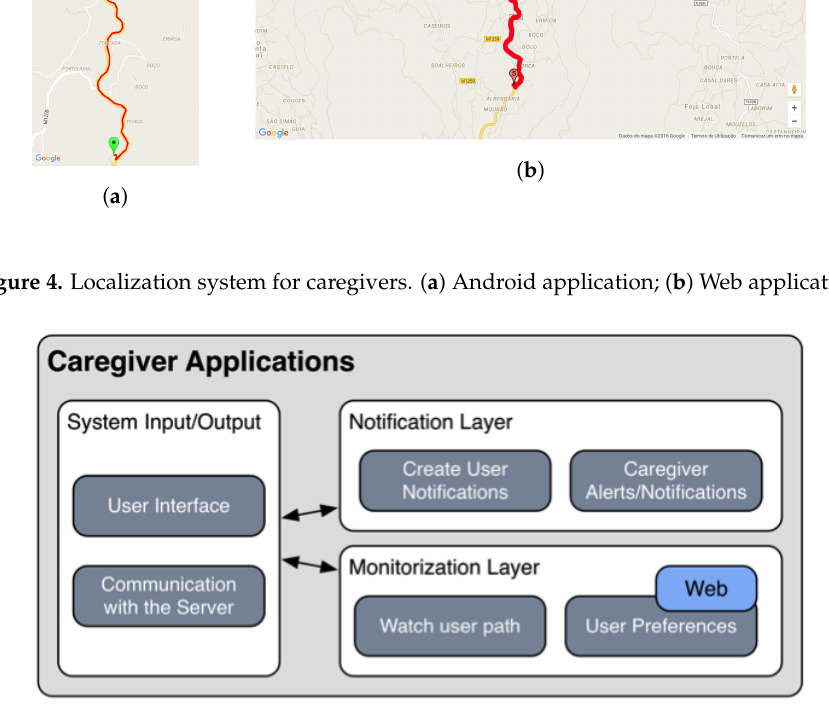
Figure 5. Detailed framework of the caregiver’s